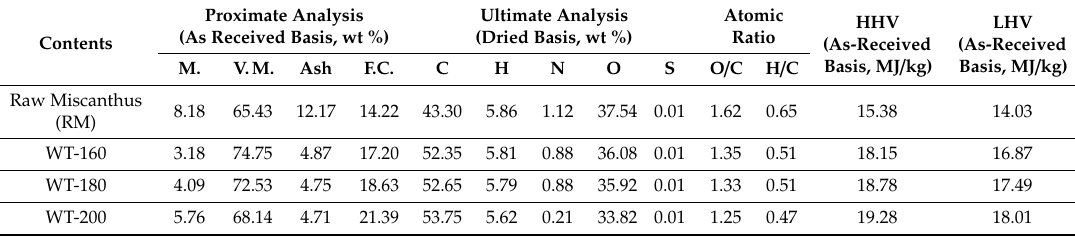
Table 1. Fuel characteristics of raw miscanthus (RM) and wet torrefaction (WT) samples.